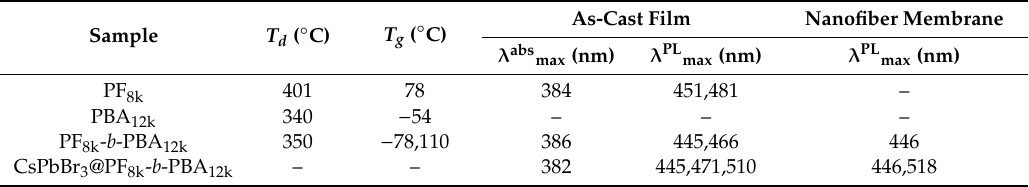
Table 2. Physical properties of the PF 8k , PBA 12k -N 3 , PF 8k - b -PBA 12k and CsPbBr 3 @PF 8k - b -PBA 12k (1 g / 400 µ